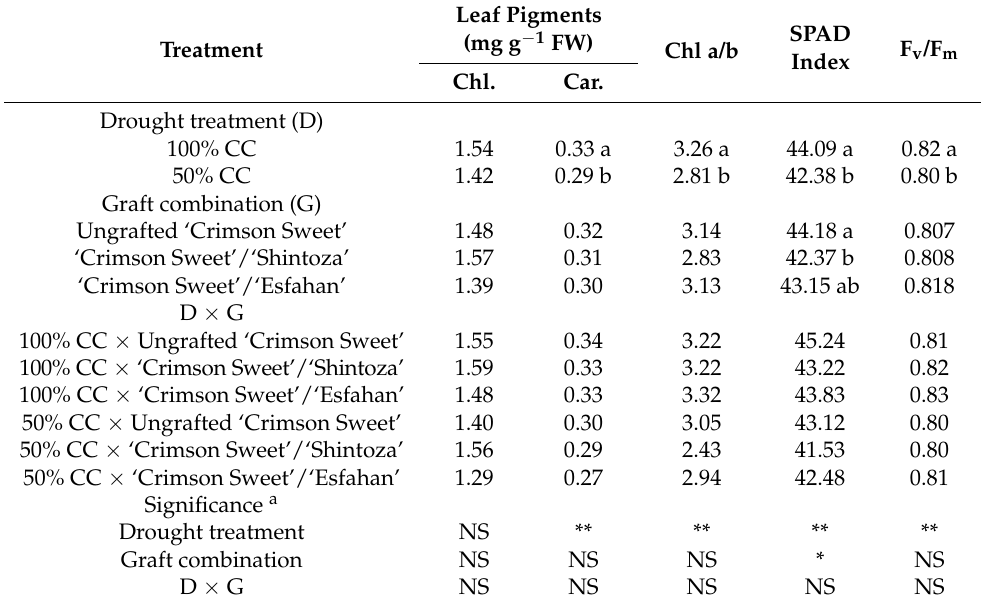
indicate significant differences according to Duncan’s multiple-range test ( p = 0.05). Table 2. Effects of graft combination and drought treatment on total chlorophyll (Chl.), carotenoids (Car.), chlorophyll a/b ratio, SPAD index and maximum quantum use efficiency of PSII (F v /F m ) of watermelon